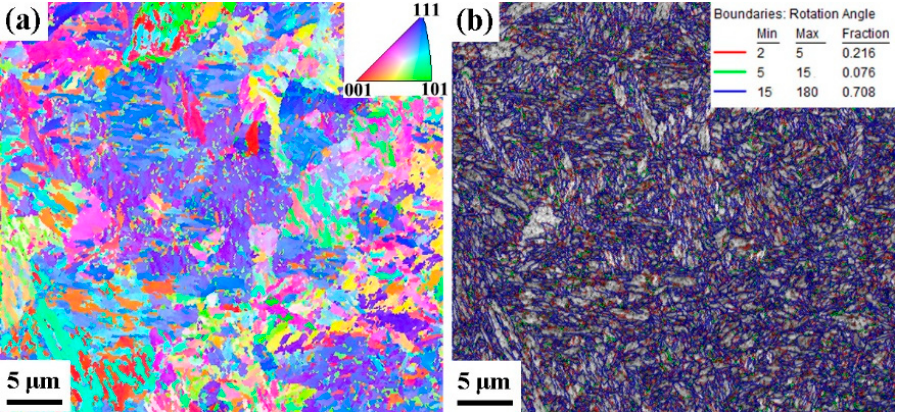
Figure 5. Electron backscattered diffraction (EBSD) of the As ‐ SLMed H13. ( a ) Inverse pole figure map. ( b ) Grain boundary misorientation map.